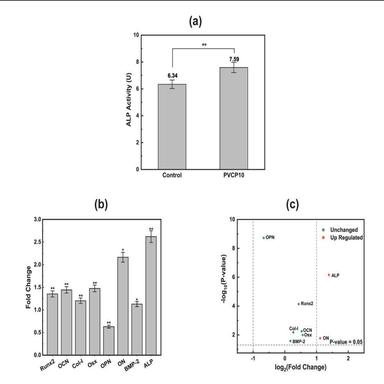
The effects of CPS-PVDF extract culture medium on osteoblast cell redifferentiation. (a) The ALP activity in osteoblast cells cultured in PVCP 10 extract and the complete (control) culture medium for 3 d. There were five technical replicates in each group (n = 5). (b) The fold changes of genes in osteoblast cells cultured in PVCP 10 extract culture medium for 3 d compared to the control group. There were four technical replicates in each group (n = 4). (c) The volcano plot of gene fold changes. The gene upr